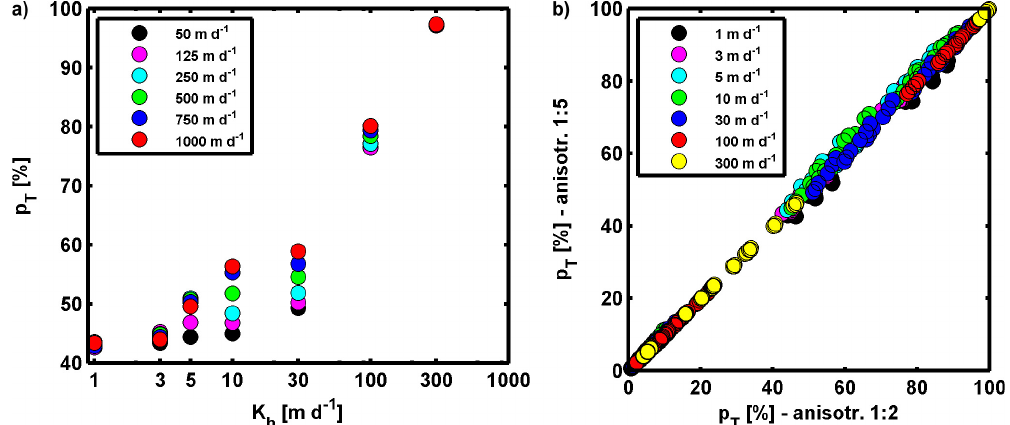
Fig. 6. (a) The influence of the hydraulic conductivity of the gravel pack ( K g ) on the intersection probability, p T , depending on the hydraulic conductivity, K h . The colors indicate different values of K g [md − 1 ]. Example for a lot size of 1 acre (L2), a drainfield size of 40m 2 (D1), and an anisotropy ratio of 1:5. The effect of K g on p T for the other lot-drainfield-configurations is similar. (b) The intersection probabilities for aquifers with an anisotropy ratio of 1:5 vs. those with an anisotropy ratio of 1:2. The colors indicate different values for K h [md − 1 ]. All conductivity-lot-drainfield-configurations are considered.